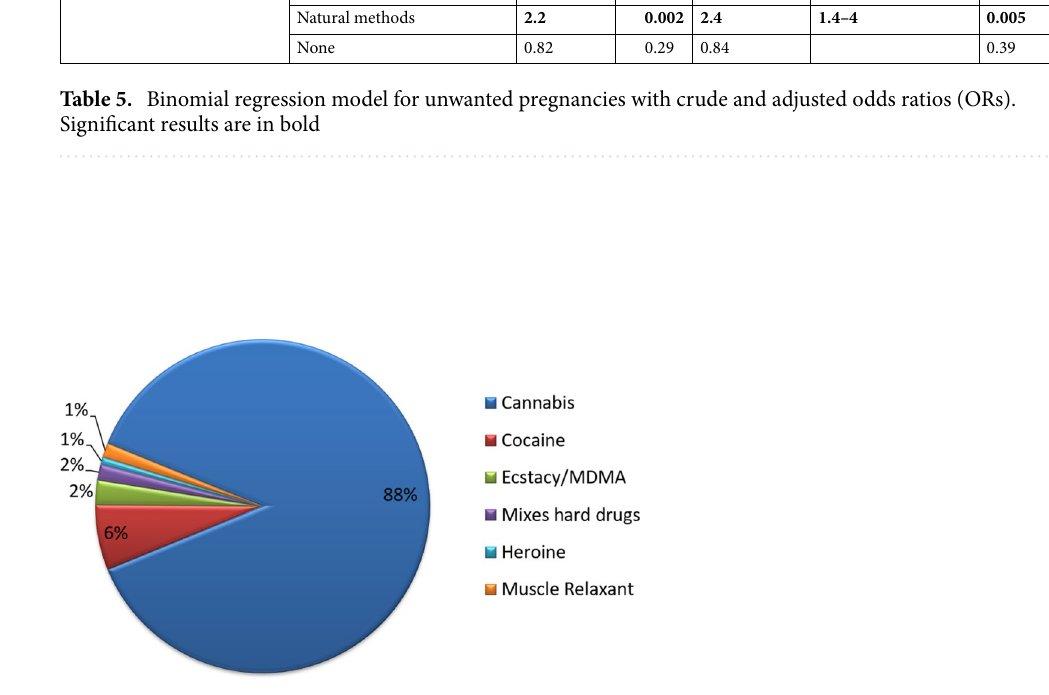
Figure 1. Recreational drugs used by 677